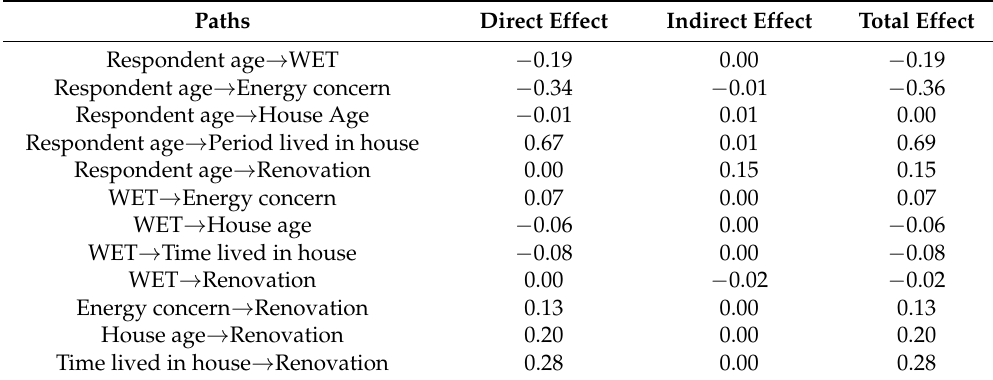
Table 3. Direct, indirect, and total effects for the renovation